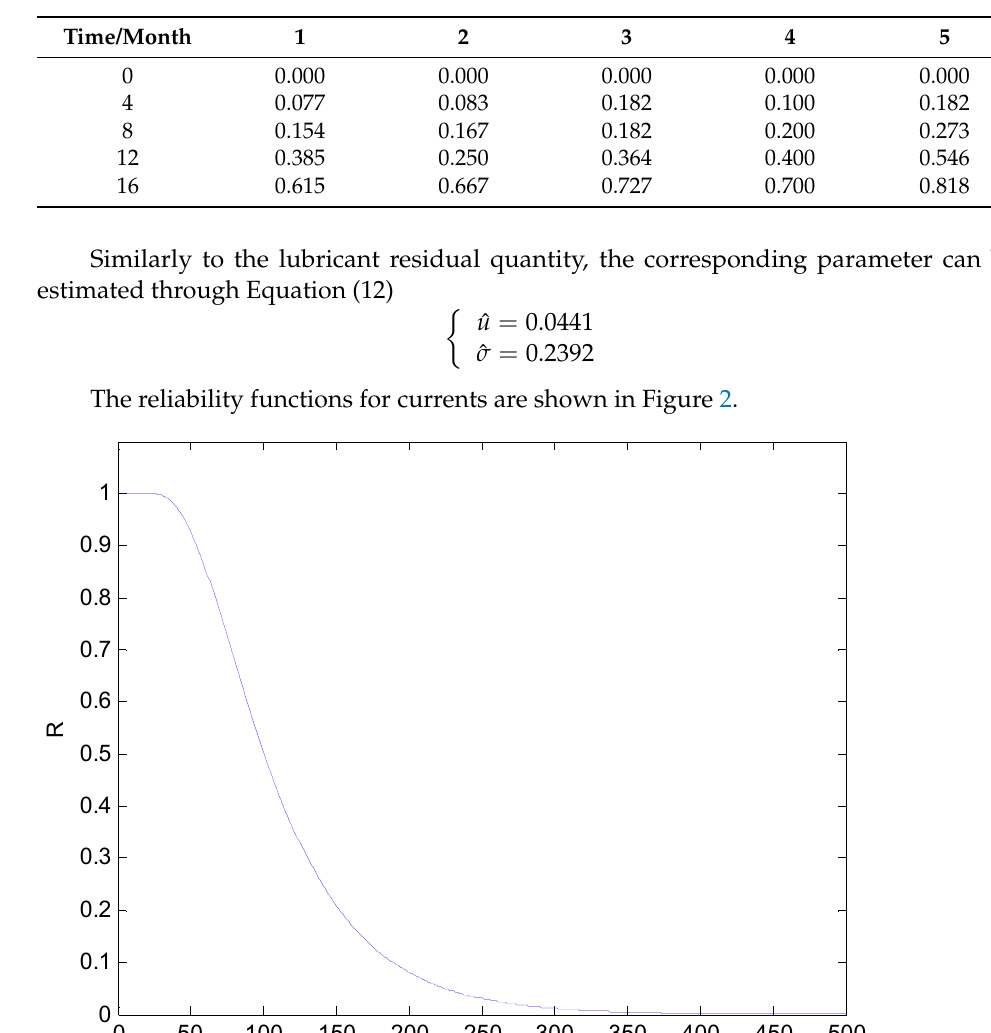
Table 3. Degradation data of momentum wheel current.